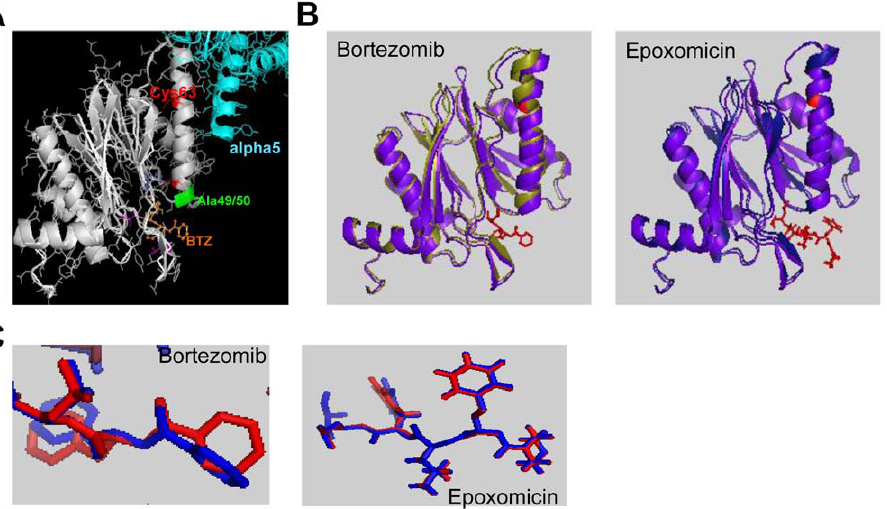
Figure 3. Cys63Phe mutation is a critical structural mutation. (A) Cys63Phe mutation is part of a critical helix at the a 5 (cyan)/ b 5 (gray) subunit interface subunit that directly points into the active site, with Ala49/50 making direct contacts with proteasome inhibitors. (B) Mutant PRE unbound (purple) overlaid with mutant PRE bound to bortezomib (olive) and epoxomicin (midnight blue). (C) Active site view of bortezomib and epoxomicin bound to the wild-type (blue) and mutant (red) PRE2 structures.